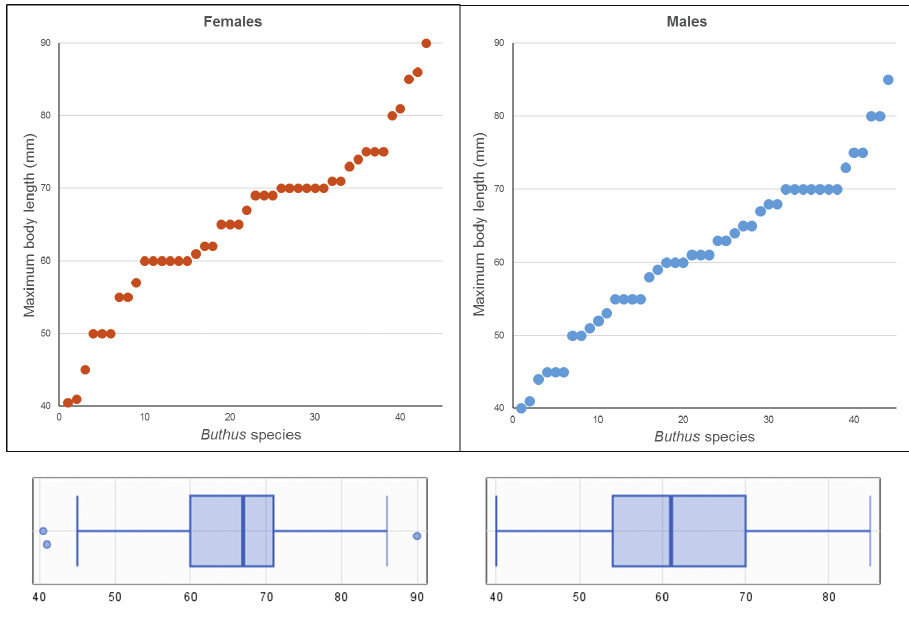
Figure 8. Chart and boxplot summary of Buthus species maximum sizes. Only the known maximum size per species is represented. Size information is only available for males from 44 species and females from 43 species. Some individual data might correspond to subadult specimens since this information is not always explicit in species